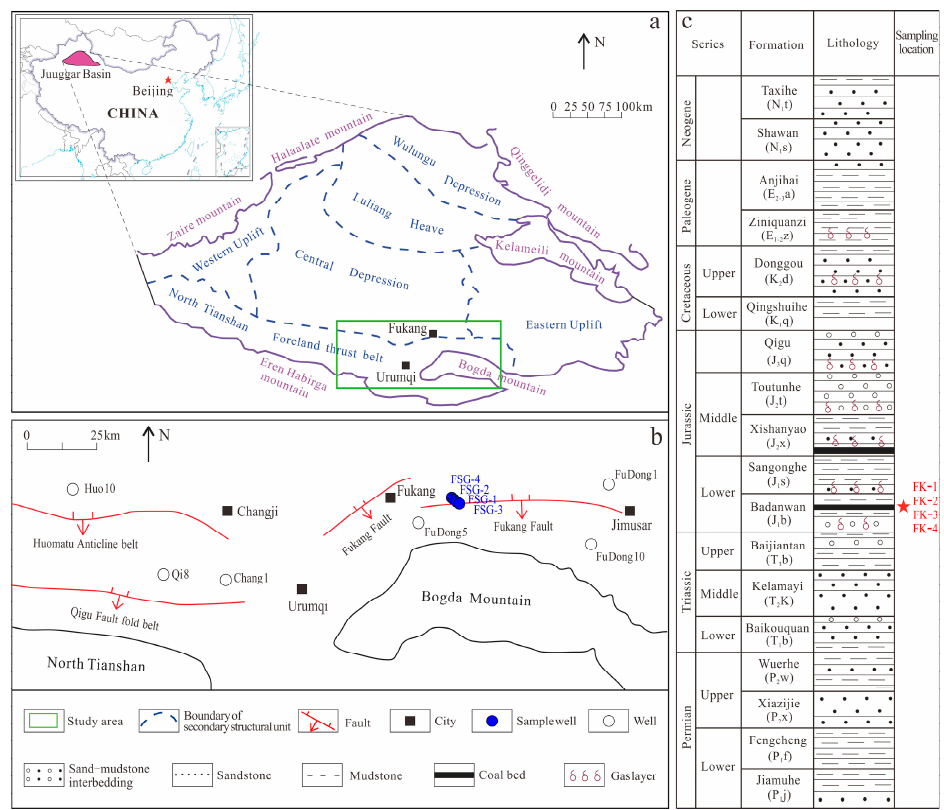
Figure 1. Geographic location, Sampling locations and lithological column: ( a ) location of the Junggar Basin, ( b ) location of the study area, and ( c ) the lithological column.